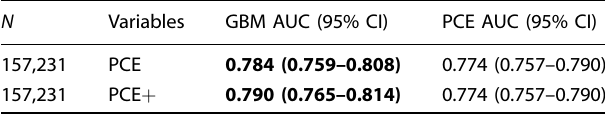
Table 3. AUCs for patients aged 40 – 79 years including those who were missing one or more PCE